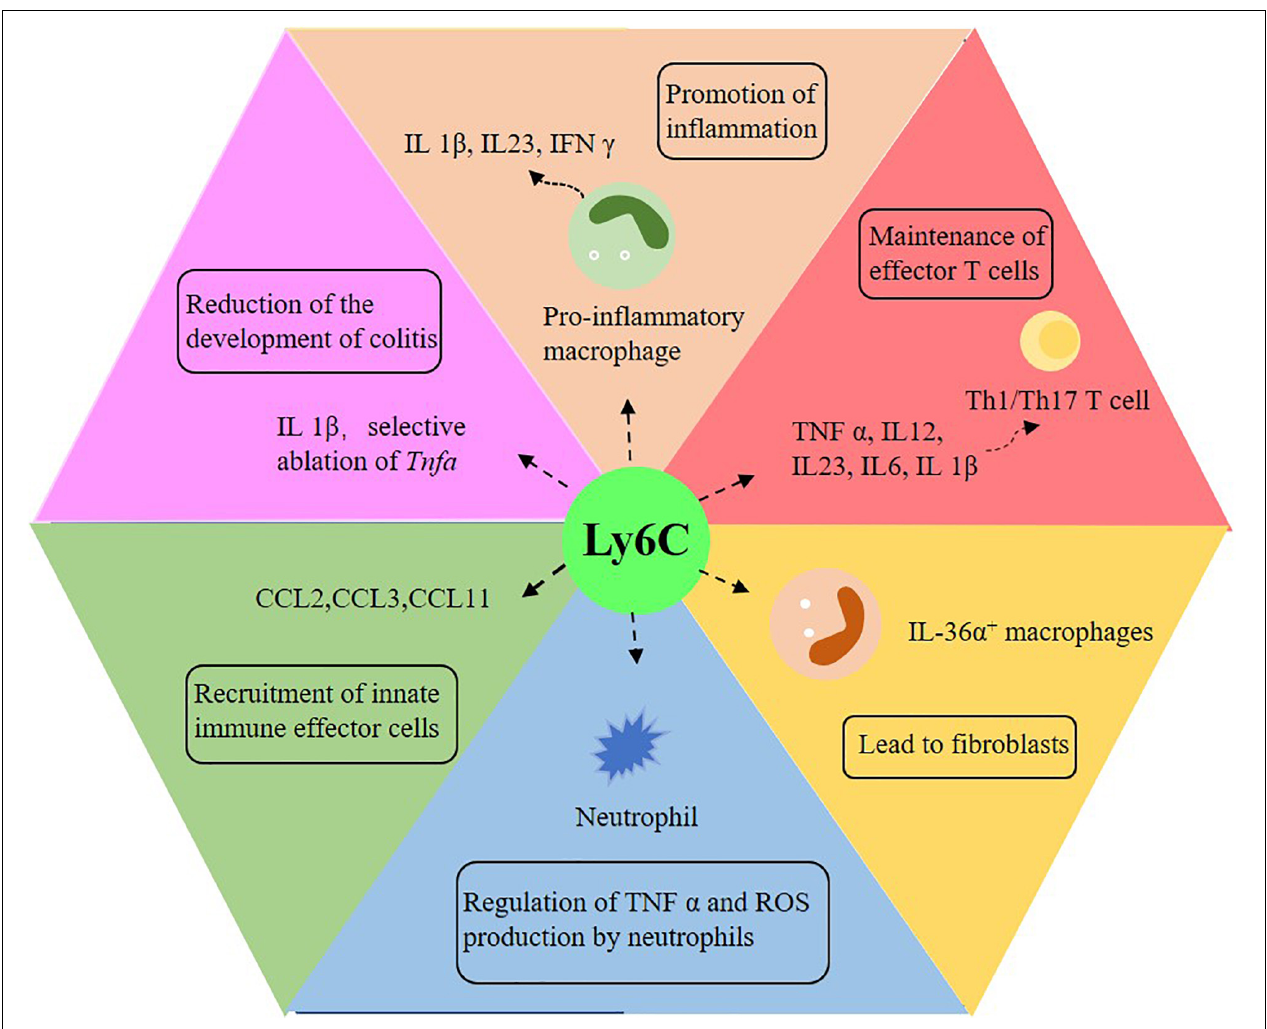
FIGURE 3 | The role of Ly6C monocytes in intestinal inflammation. Ly6C plays an important role in promoting intestinal inflammation, reducing colitis, activating T cells, promoting tissue fibrosis, regulating neutrophils and recruiting innate immune effector cells. IL: interleukin; TNF- α : tumor necrosis factor- α ; IFN- γ : interferon- γ ; Th1: interferon- γ -producing type 1 helper T cells; Th17: interferon- γ -producing helper T